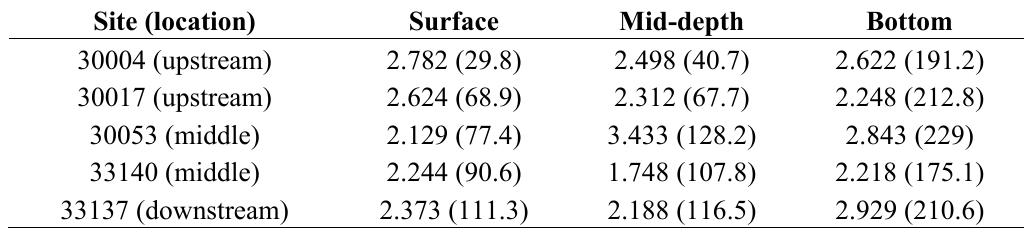
Table 2. Distribution of dissolved organic carbon (mg·L − 1 ) and turbidity (nephelometric turbidity units—NTU) (in brackets) distribution spatially and vertically in Lake Wivenhoe post flood